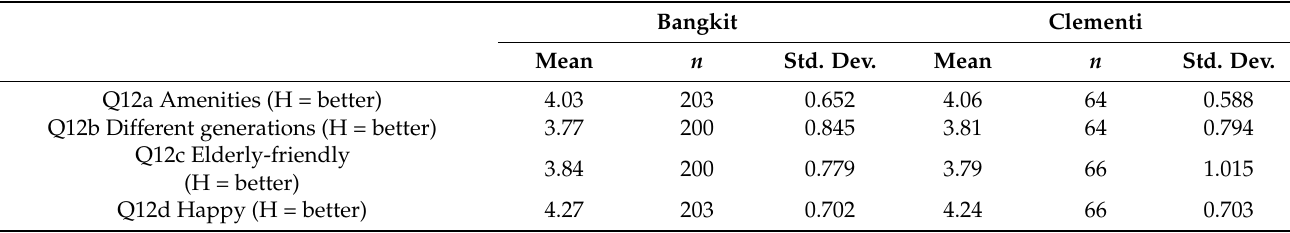
Table 13. Comparison of overall satisfaction with the neighbourhood (Question 12 of Socio-sensory Survey, Appendix A).